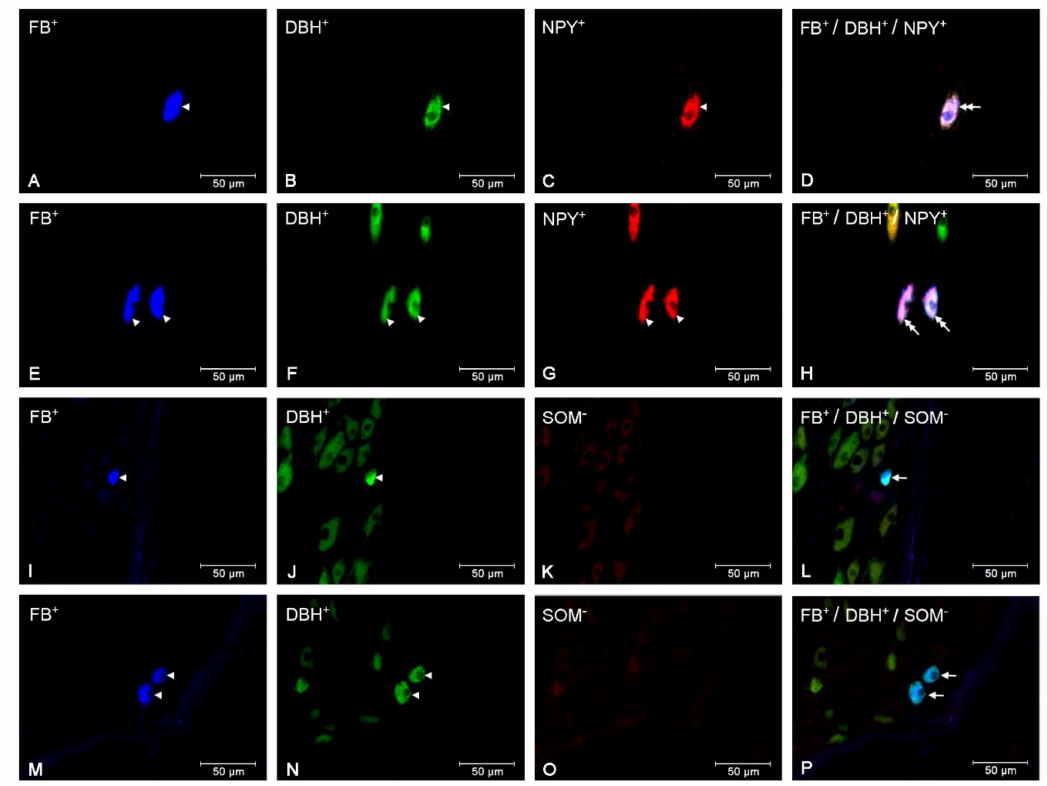
Figure 3. Micrographs demonstrating the presence of D β H (B, F, J, N), NPY (C, G) and SOM (K, O) in the CaMG uterine perikarya of gilts from the CON ( A – D ), SAL ( I – L ) and E. coli ( E – H , M – P ) groups. The arrowhead indicates: Fast Blue (FB)-positive perikaryon, perikaryon presenting positive staining for D β H and NPY and perikaryon presenting positive staining for D β H. The double arrow indicates FB-positive uterine perikaryon expressing D β H and NPY. The arrow indicates FB-positive uterine perikaryon expressing D β H. The photographs (D, H, L, P) were made by digital superimposition of three color channels: FB-positive (blue), D β H-positive (green) and NPY- or SOM-positive (red). One large uterine perikaryon D β H and NPY immunoreactive is visible in the gilt of the CON group ( A – D ). In the CaMG of E. coli group, an elevation in the population of large perikarya containing these substances is observed ( E – H ). One small perikaryon expressing D β H, but not SOM, is present in the ganglion of the SAL group ( I – L ). In the E. coli group, two small perikarya expressing D β H, but not SOM, are observed in the CaMG ( M – P